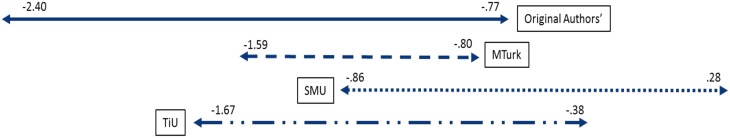
After writing about comfort food, threatened, securely attached participants should experience lower levels of loneliness as compared to insecurely attached.